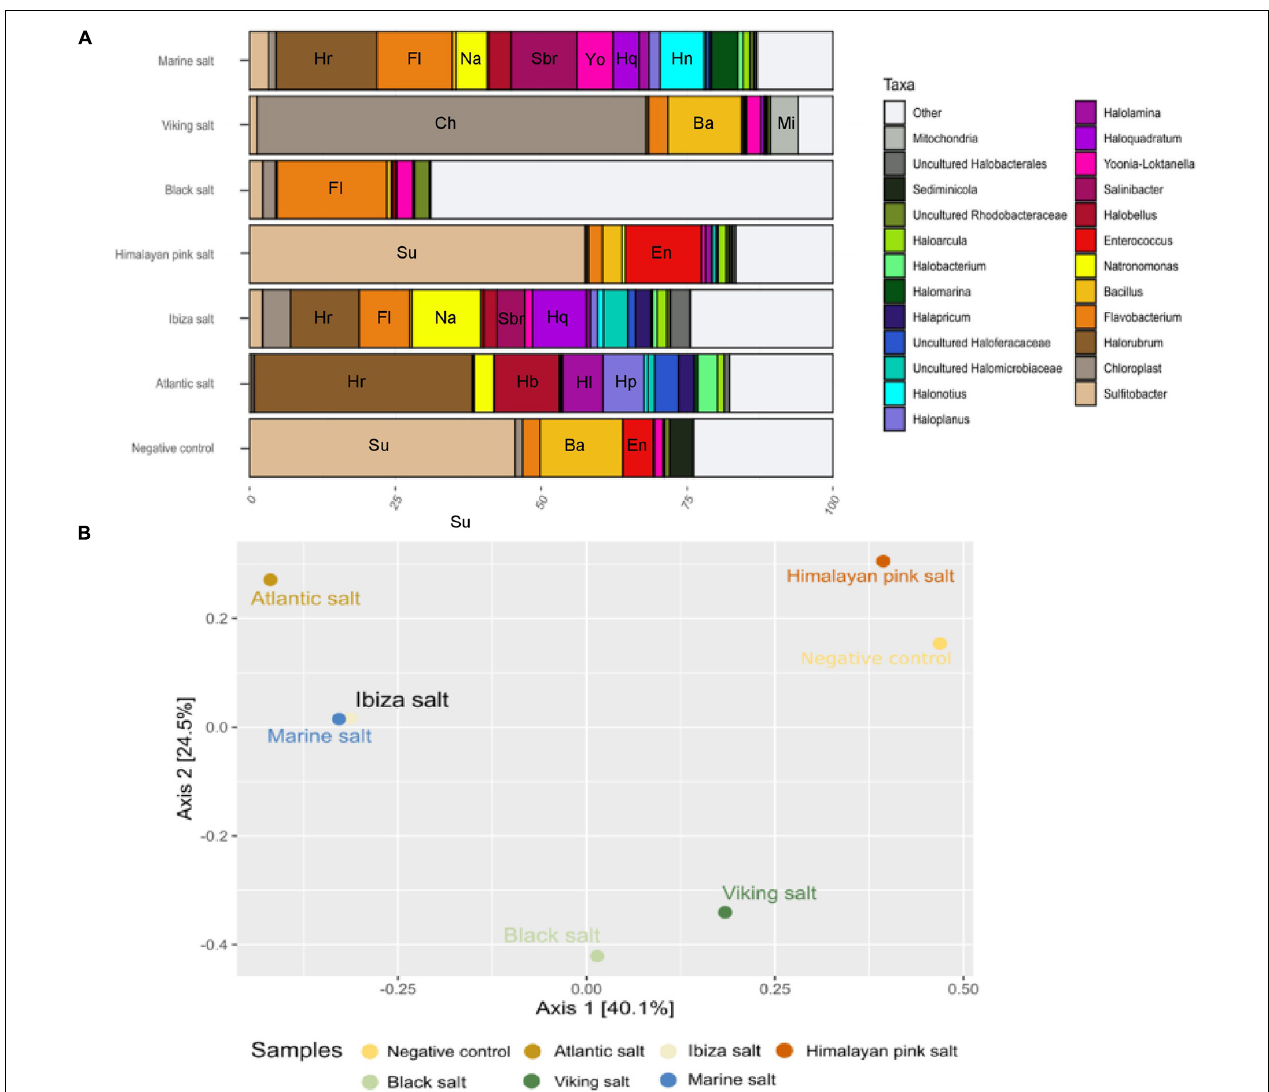
FIGURE 3 | (A) Microbial composition of table salt samples after 16S rRNA gene sequencing. The abbreviation is correlated to the genus name and highlighted the most frequent genera: Su, Sulfitobacter ; Ba, Bacillus ; En, Enterococcus ; Hr, Halorubrum ; Hb, Halobellus ; Hl, Halolamina ; Hp, Haloplanus ; Fl, Flavobacterium ; Na, Natronomonas ; Sbr, Salinibacter ; Hq, Haloquadratum ; Ch, chloroplast; Mi, mitochondria; Yo, Yoonia_Loktanella ; Hn; Halonotius . (B) Beta diversity (PCoA) based on Bray–Curtis dissimilarity metric. Distances to the linear statistical correlation indicate the similarity of the microbial diversity of each sample affected by the origin of those